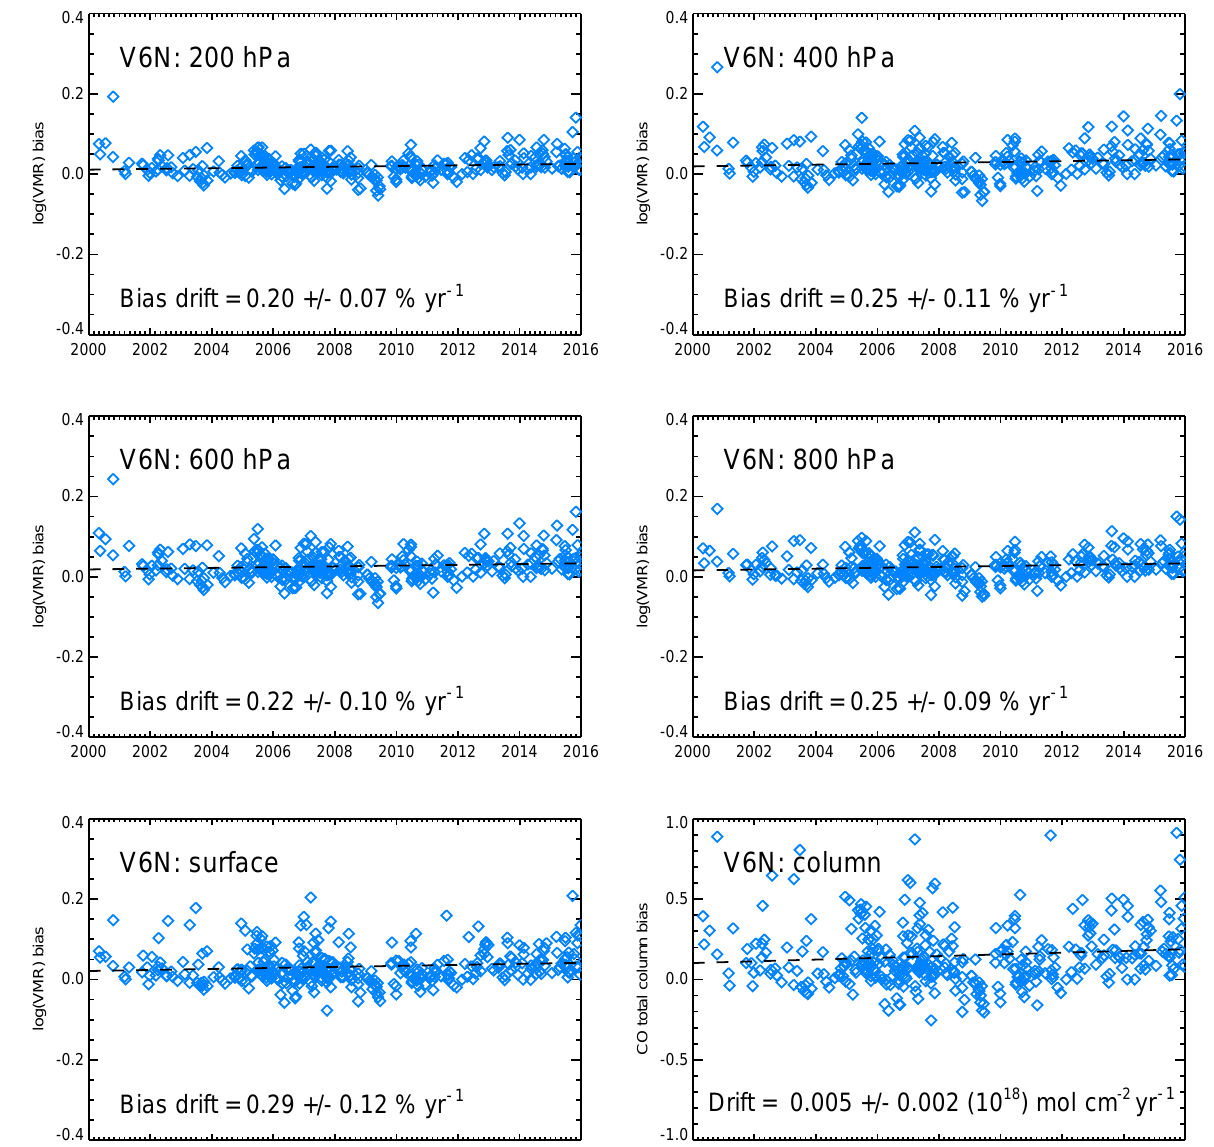
Figure 13. Retrieval bias drift for V6 NIR-only products based on the NOAA flask measurements. See caption to Fig. 11.